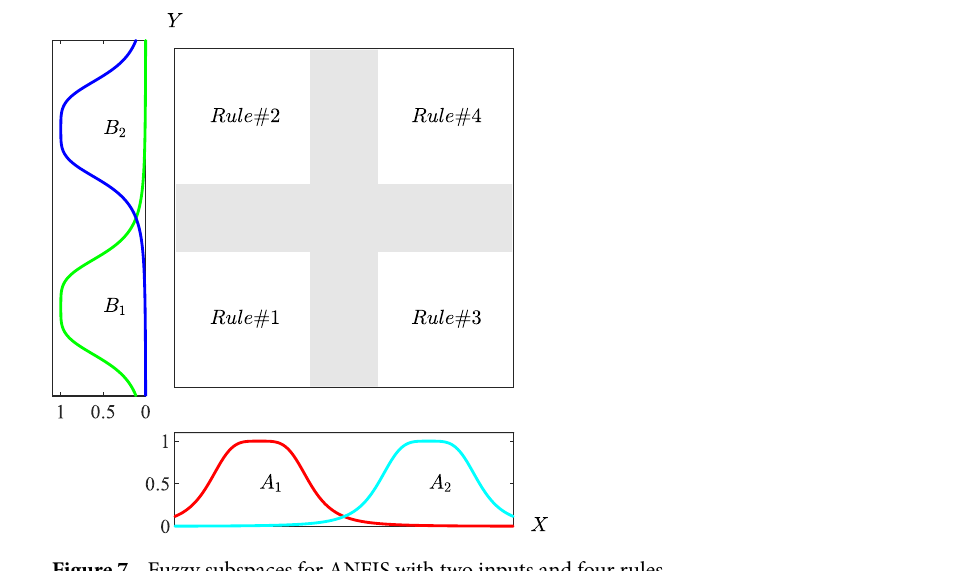
Figure 7. Fuzzy subspaces for ANFIS with two inputs and four